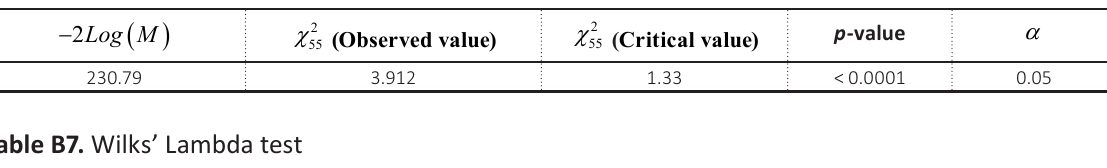
Table B6. Box’s M test